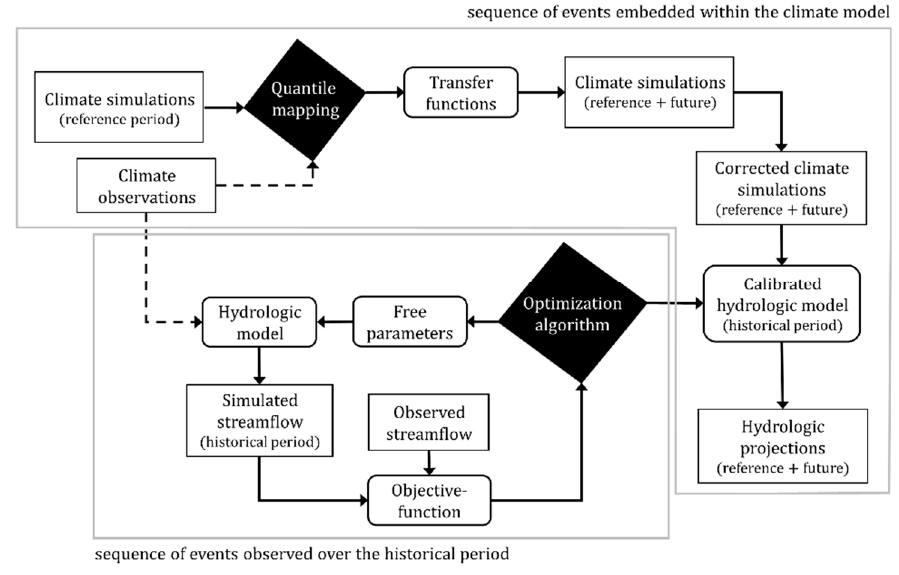
Figure 1. A conventional configuration of a hydroclimatic modeling chain.